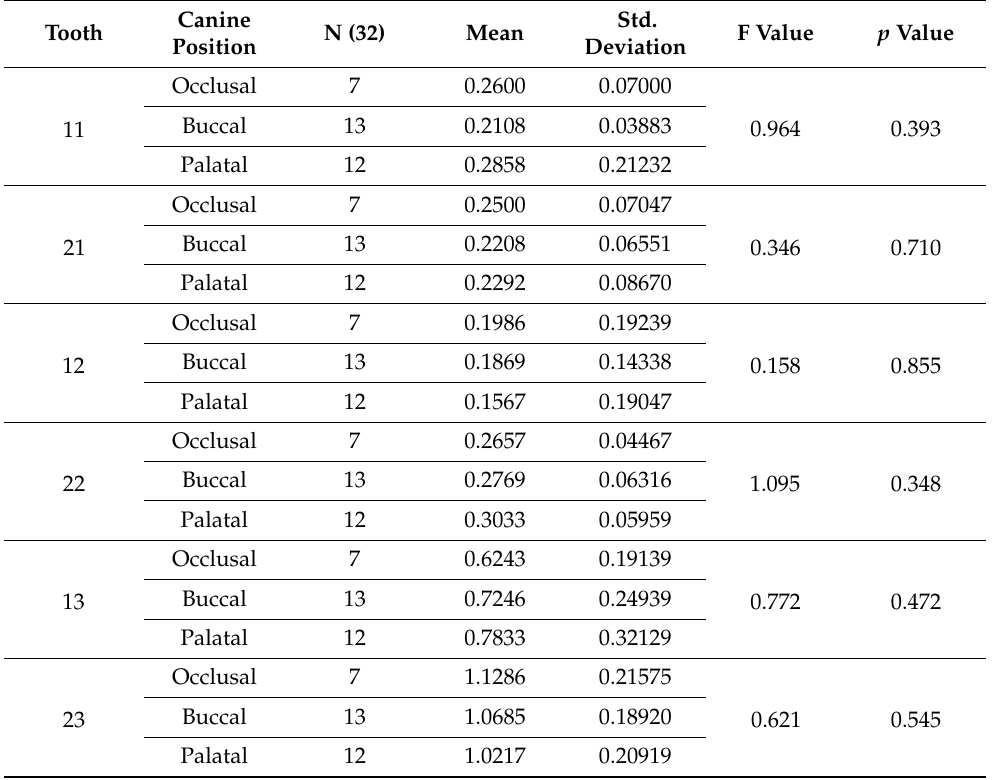
Table 5. ANOVA test results of mean root resorption for the measured tooth (#11, #21, #12, #22, #13, #23) within occlusal, buccal, palatal canine position